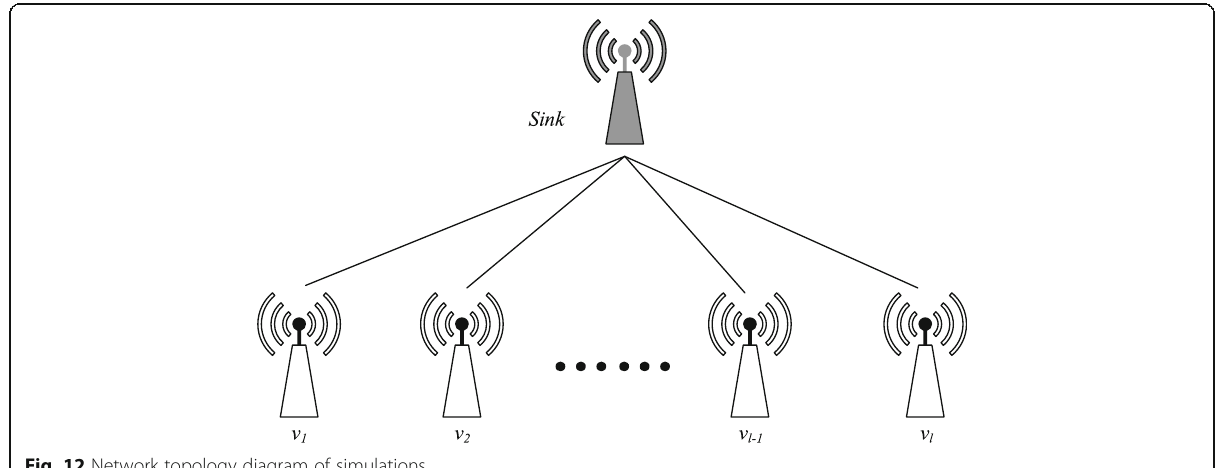
Fig. 12 Network topology diagram of simulations